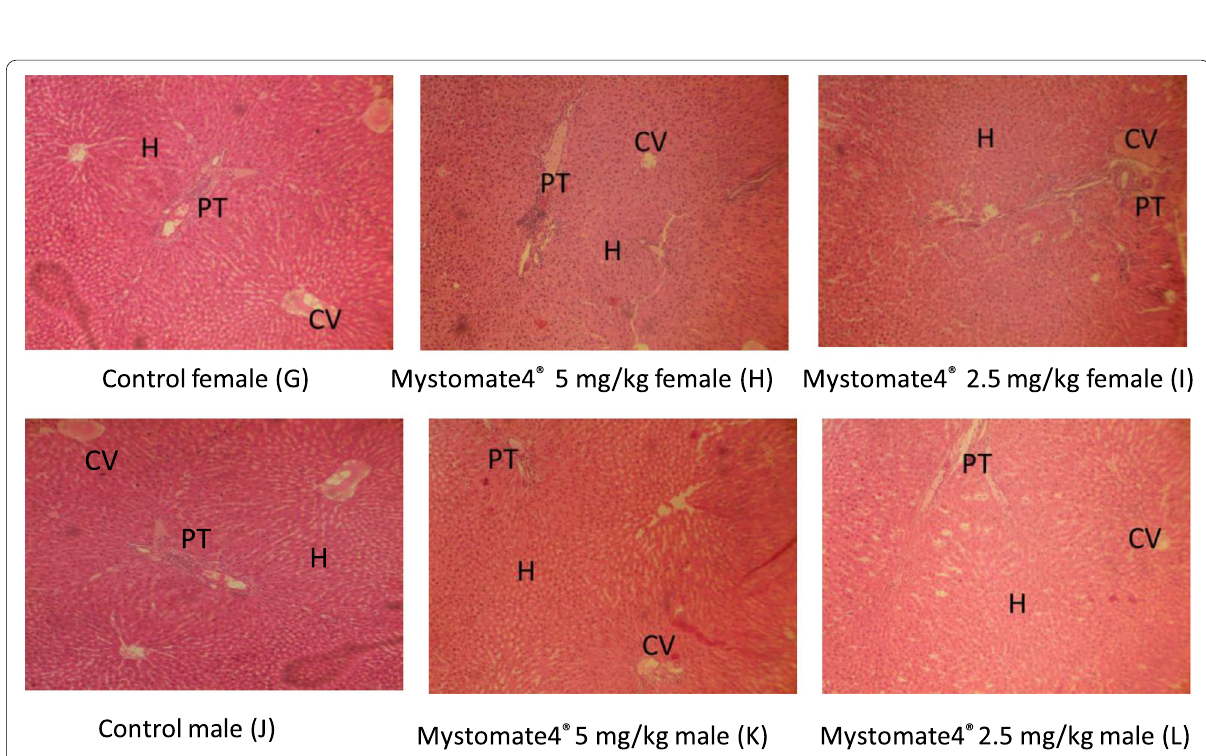
Fig. 4 Photomicrograph of the liver tissue slides in control, 5 mg/kg-male, 5 mg/kg-female, 2.5 mg/kg-male and 2.5 mg/kg-female Mystomate4 ® treated rats (H&E stained, x400 magnification, Portal tract